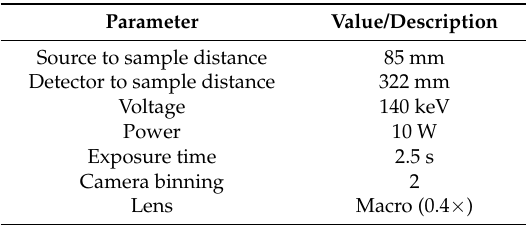
Table 1. Scanning parameters and their values.